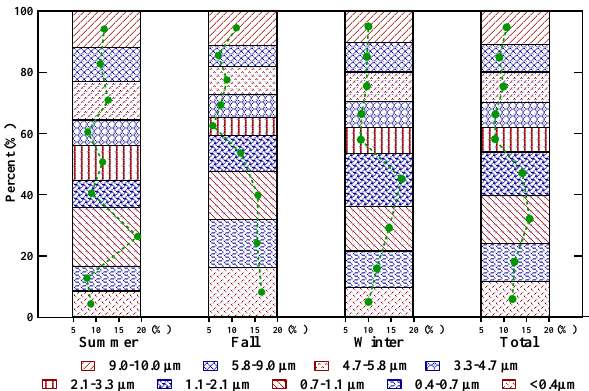
Fig. 3. Size distribution of Hg P mass in each season and over the whole study